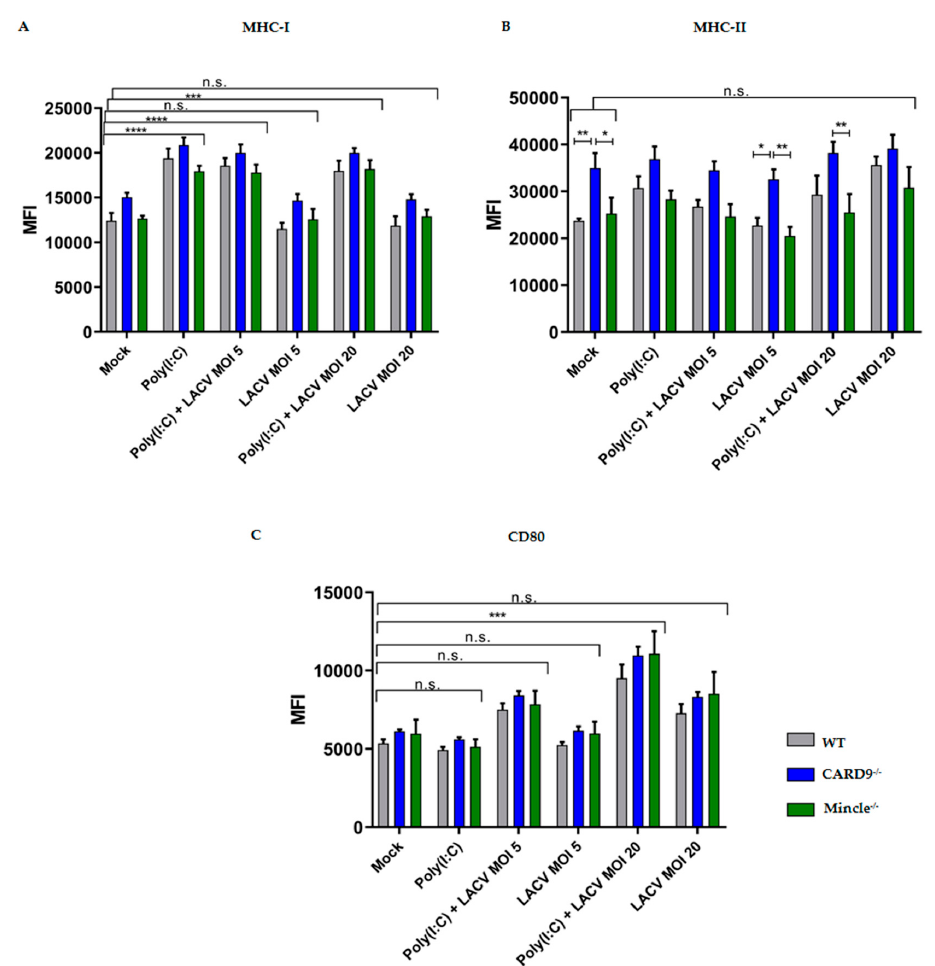
Figure 4. Effector functions of Mincle − / − , CARD9 − / − , and WT DCs stimulated with LACV. ( A ) Surface expression of MHC-I. ( B ) Surface expression of MHC-II. ( C ) Surface expression of CD80 in Mincle − / − , CARD9 − / − or WT DCs after 24 h of stimulation. Data represented are mean ± SEM of three independent experiments. Data are presented as MFI (median fluorescence intensity)